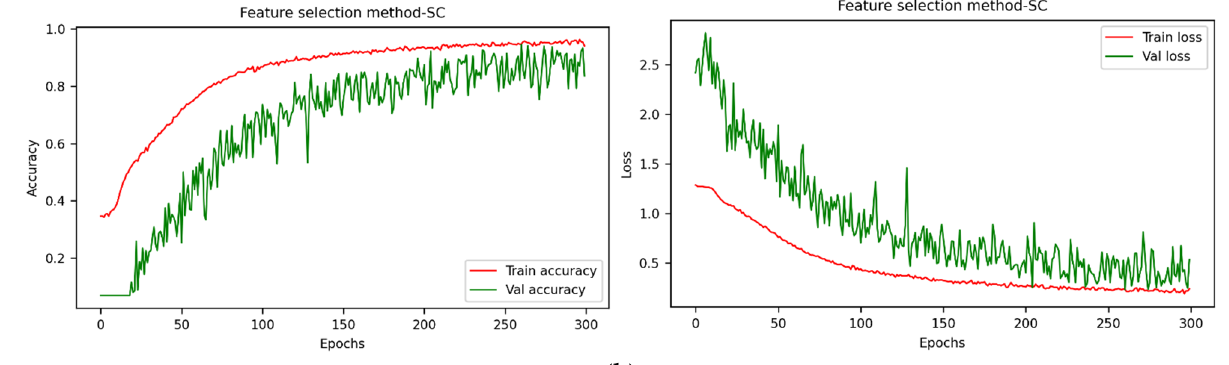
Figure 10. Training process of DCNN model based on characteristic wavelength. ( a ) Iterative curves of training set and validation set based on SPA; ( b ) iterative curves of training set and validation set based on SC algorithm.